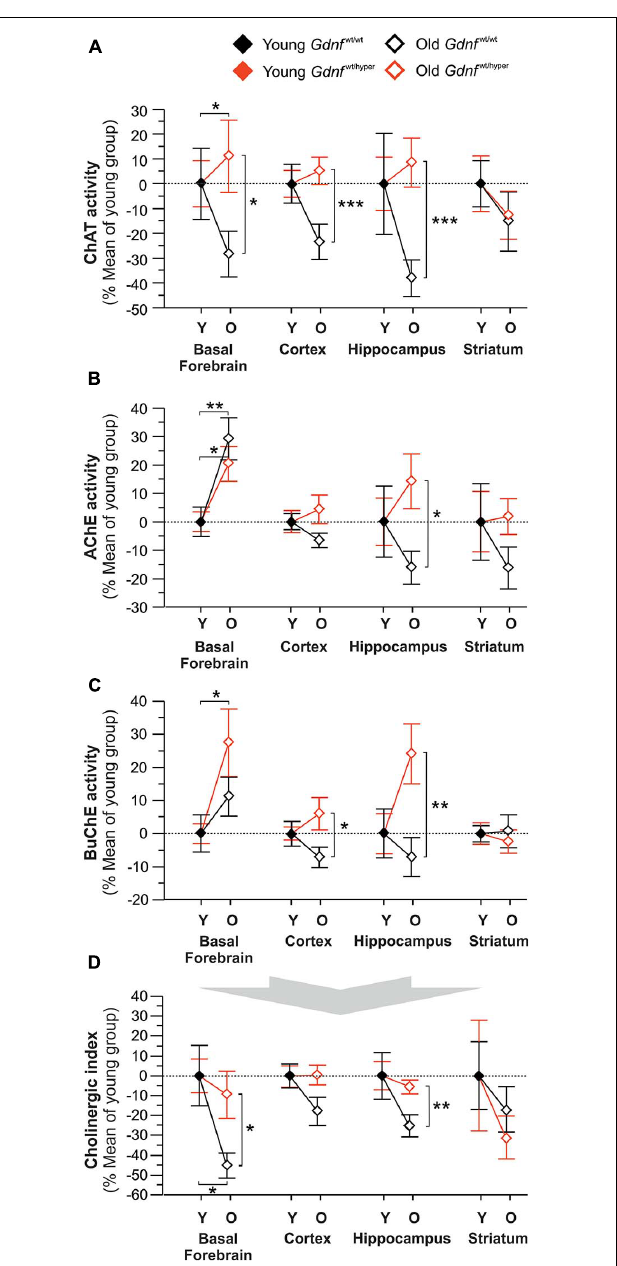
FIGURE 1 | Changes in the key cholinergic enzymes in young and old Gdnf wt / wt and Gdnf wt / hyper mice. The activity of the acetylcholine-biosynthesizing enzyme, ChAT (A) and acetylcholine-degrading enzymes, AChE (B) and BuChE (C) measured in different brain regions of young (Y) and old (O) Gdnf wt / wt and Gdnf wt / hyper mice. The data are given as percent of mean values in young animals. The raw data is provided in the Supplementary File . (D) The corresponding changes in Cholinergic index in the Gdnf wt / hyper mice and wild-type littermates. The Cholinergic index provides a measure between ACh biosynthesis by ChAT relative ACh-biodegradation by cholinesterases (AChE and BuChE). This index is calculated as the ratio between ChAT activity to the ChE activity. n = 10 per group (young) and n = 8 per group (old). Data are presented as mean ± SEM. * p < 0.05; ** p < 0.01; *** p < 0.001. AChE, acetylcholinesterase; BuChE, butyrylcholinesterase; ChAT, choline acetyltransferase.